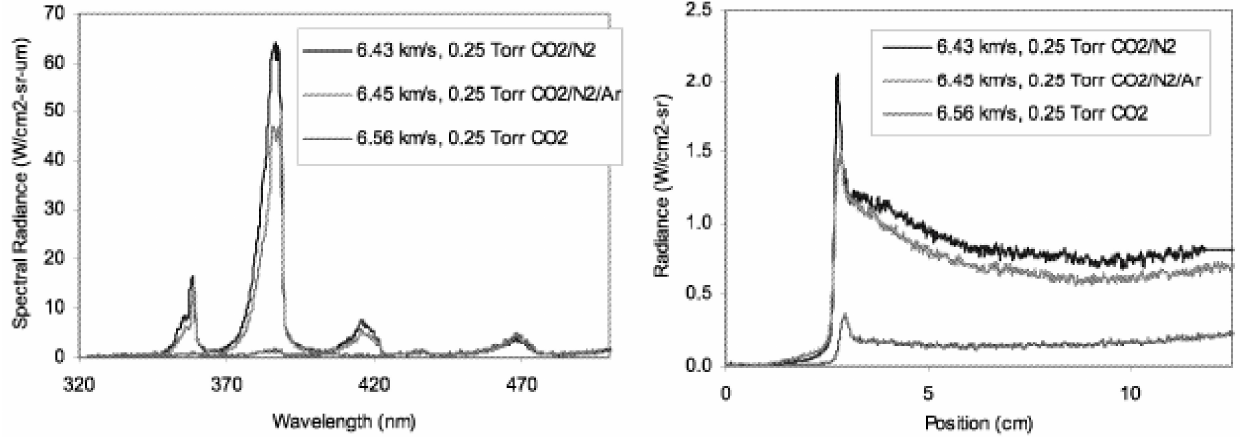
Figure 26. EAST data for different mixtures: Left: Spectral radiation; Right: Radiation as function of position (from [26]).